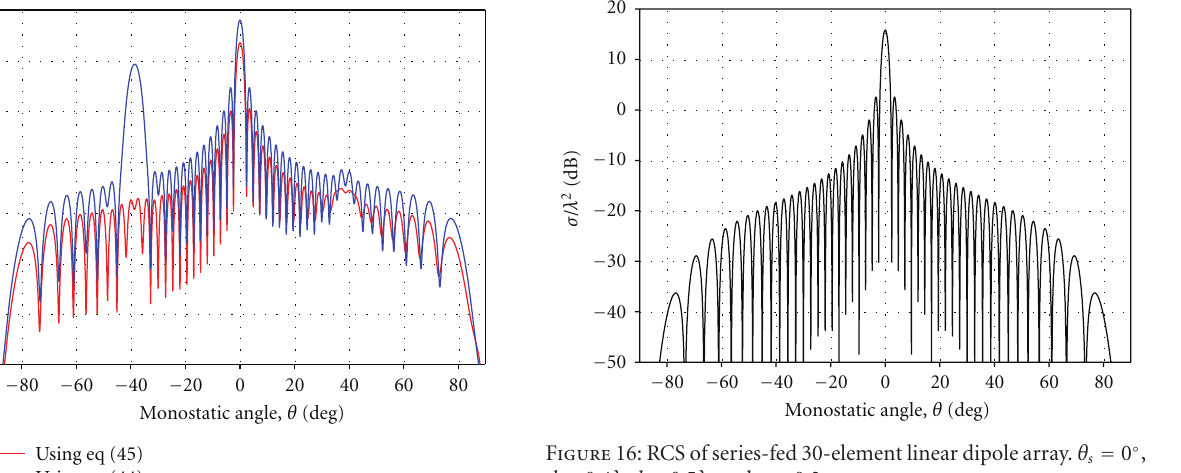
r r r . 2; uniform unit r = p = c = l = 0